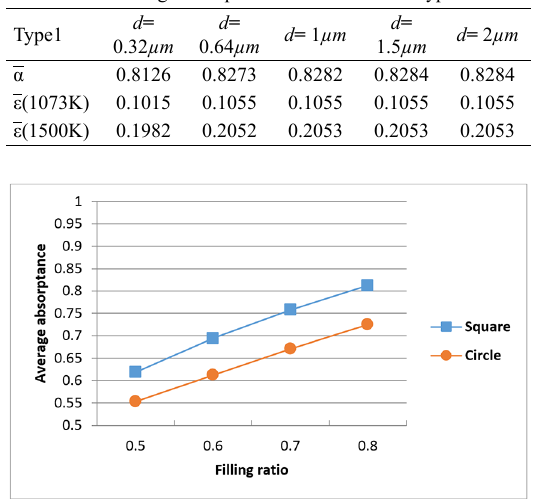
Figure 5. Average absorptance of PhC with patterned square or circular structures in different filling ratios.